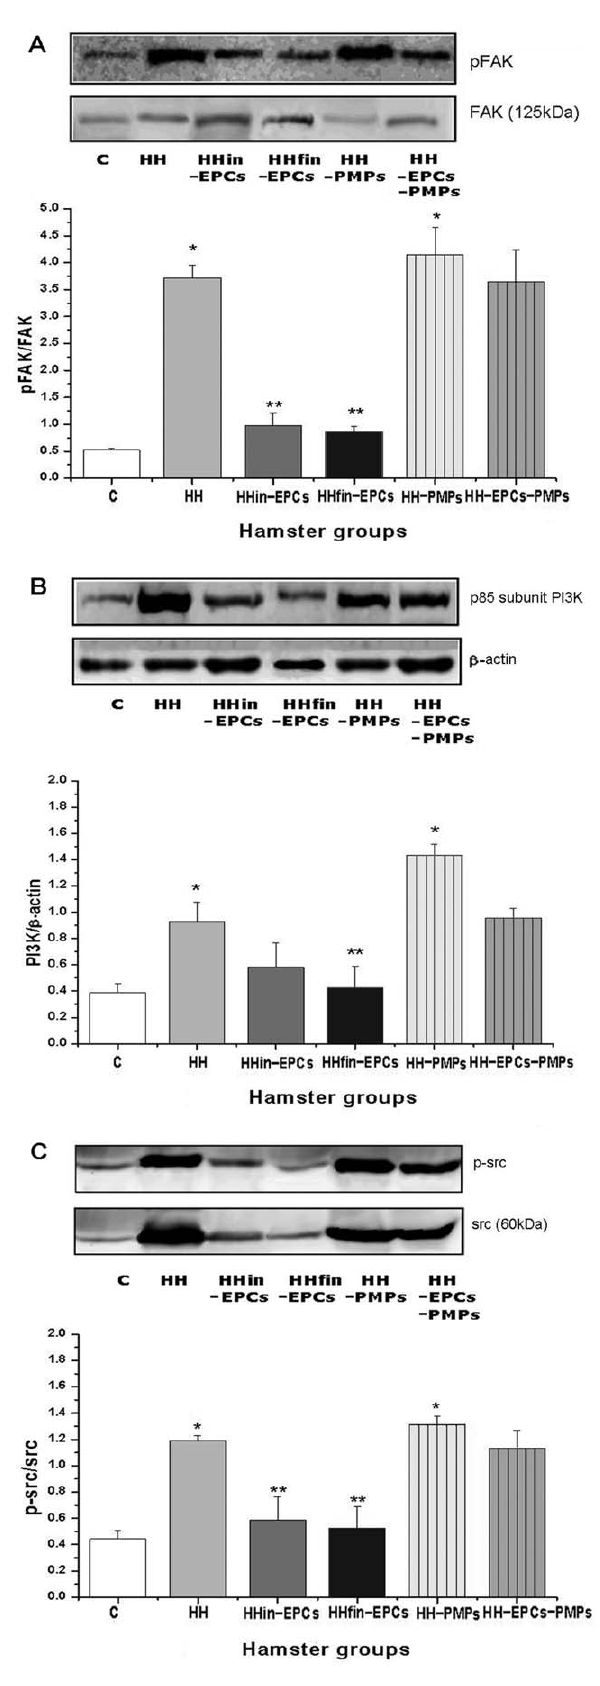
Figure 2. Representative immunoblots and densitometric data for the platelets from hamster groups: control (C), hyperten- sive-hypercholesterolemic (HH), prevention (HHin-EPCs), re- gression (HHfin-EPCs), HH treated with PMPs (HH-PMPs) and HH treated with EPCs and PMPs (HH-EPCs-PMPs). (A): pFAK, FAK, (B): p85 subunit of PI3K, b - actin, (C): p-src, src. (*) Groups vs Control: p # 0.05. (**) Groups vs HH: p #